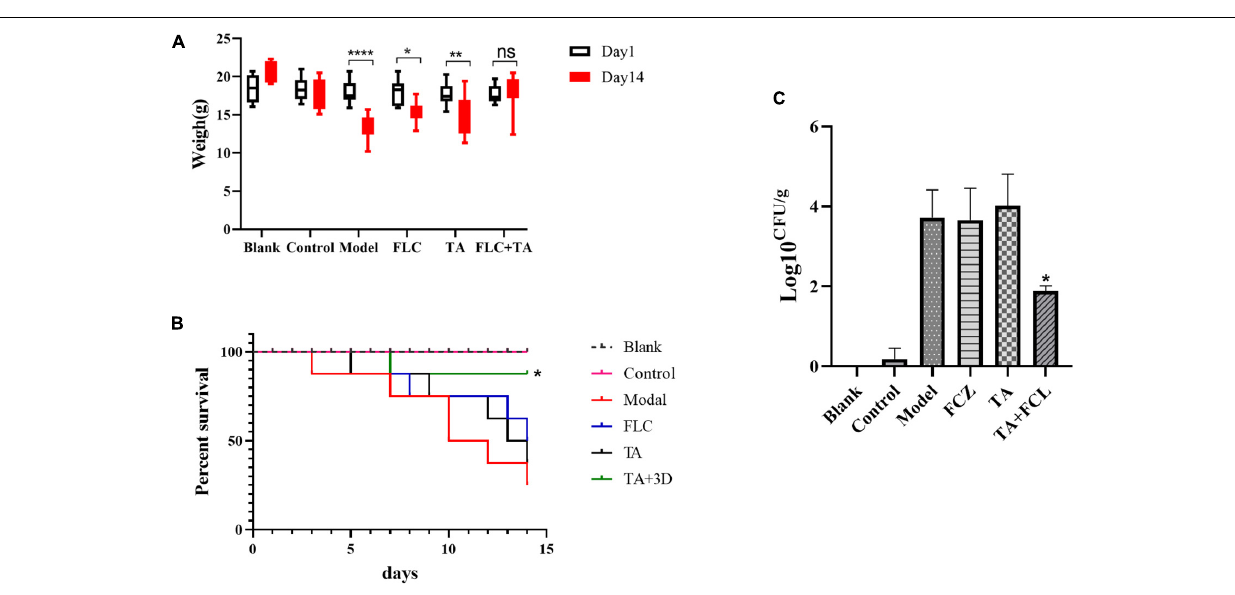
FIGURE 4 | The effect of FLC combined with TA on the infection of drug-resistant C. albicans in vivo . (A) The effect of FLC combined with TA on the mice body weight. The mice in the model group, TA, and FLC groups significantly lost weight compared with the weight at the first and last days of administration. In contrast, the body weight of the mice in the FLC and TA combination group was not significantly changed. (B) The effect of FLC combined with TA on the survival rate of mice. The survival rate of mice was higher in the combined administration group than in the model group. (C) Kidney fungal burden. The number of kidney fungi in mice significantly reduced in the TA combined with the FLC group after 14 days of treatment compared with the model group. * P < 0.05, ** P < 0.01, **** P <